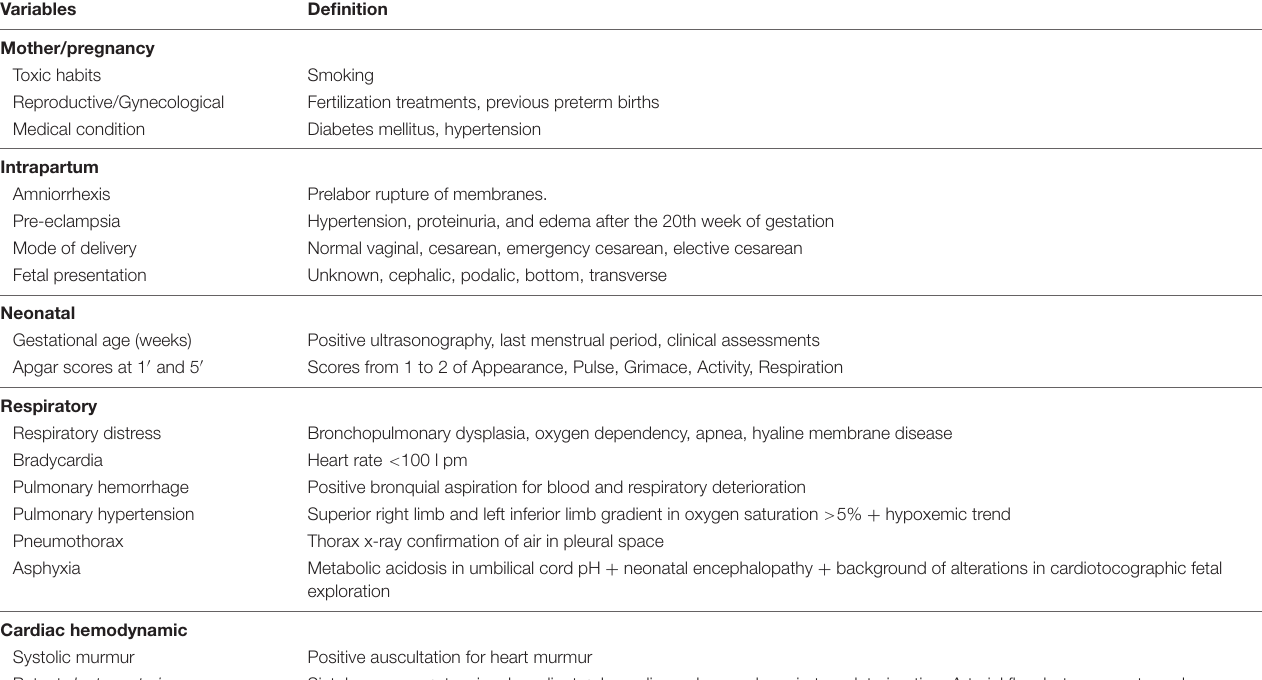
TABLE 1 | Neonatal clinical variables included in this